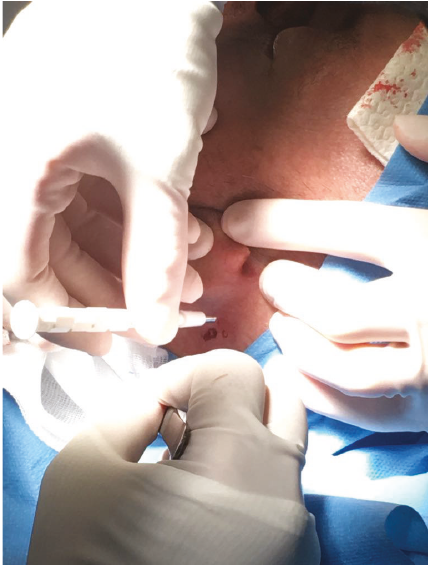
Figure 2: Harvest of the 3mm punch biopsies from the previously deepithelialized skin.